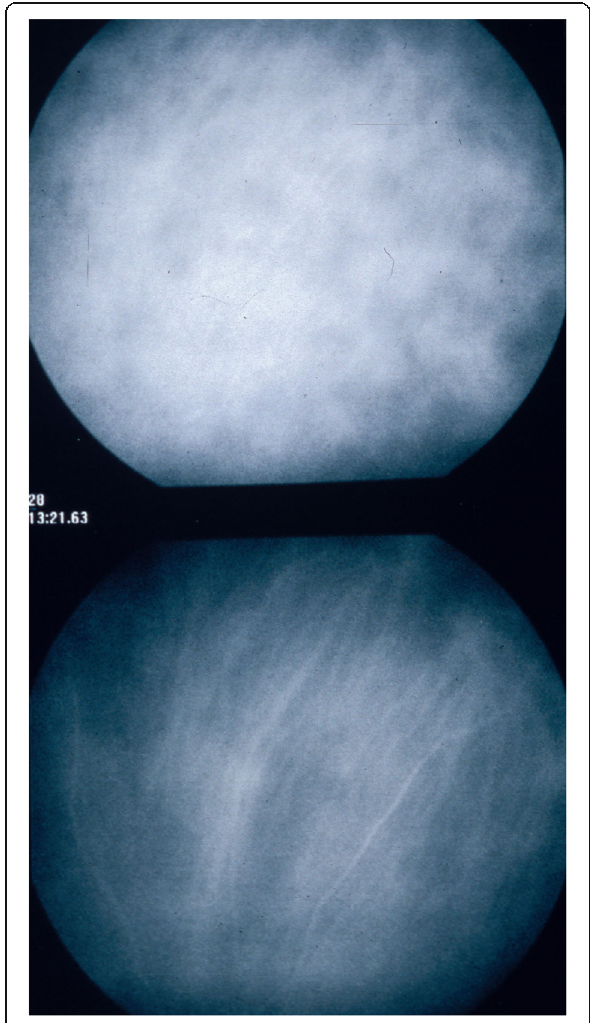
Fig. 9 Indocyanine green angiography (ICGA), type 2 pattern found in stromal choroiditis. Typical round HDDs of similar size evenly distributed caused by the presence of inflammatory foci that impair the diffusion of the ICG dye showing granulomas in negative in case of Vogt-Koyanagi-Harada (VKH) disease. Choroidal vessels are no more distinct and appear fuzzy with diffuse hyperfluorescence hiding the HDDs (Top picture). After 3 days of intravenous corticosteroids the choroidal vessels are again distinctly visible, and HDDs have partially resolved